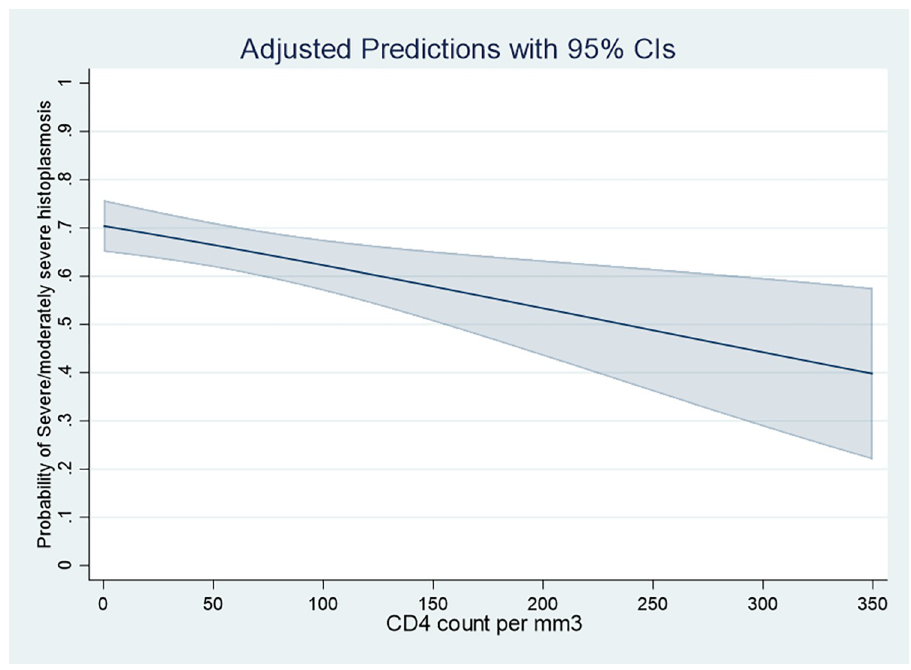
Fig 1. Probability of severe progressive disseminated histoplasmosis by CD4 count.